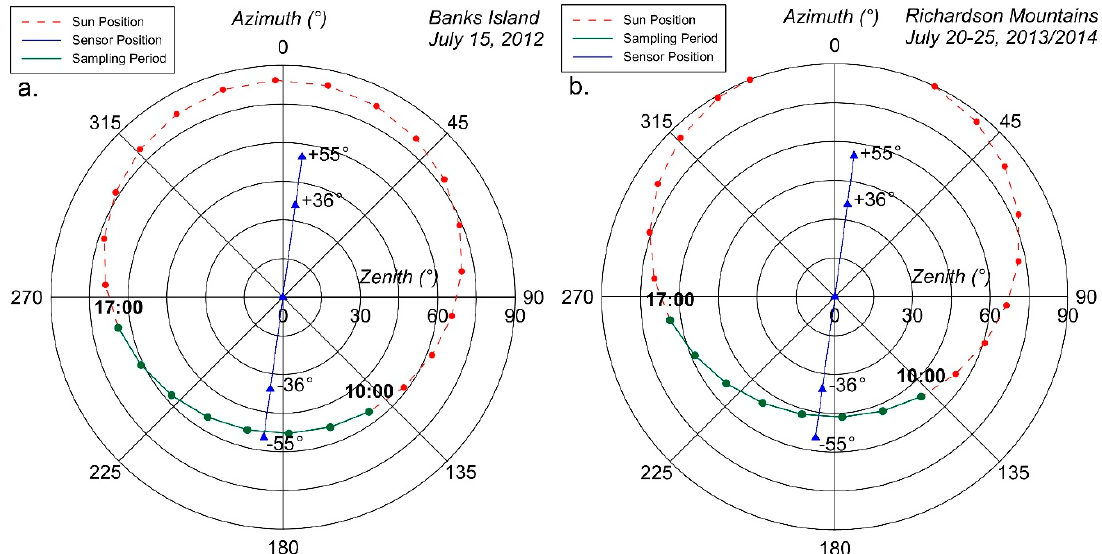
Figure 4. Approximate sun / sensor geometry for ( a ) the high-Arctic (Banks Island) and ( b ) the low-Arctic field sites (Richardson Mountains). Sun position (red) is shown using 1-hour increments for the period when measurements were taken in the field. Spectral sampling periods (green) are the sampling times for each day.